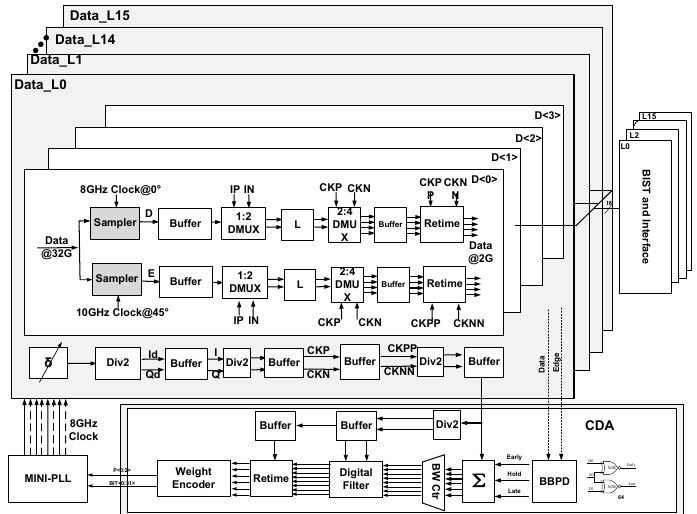
Figure 4. Data path and clock path.